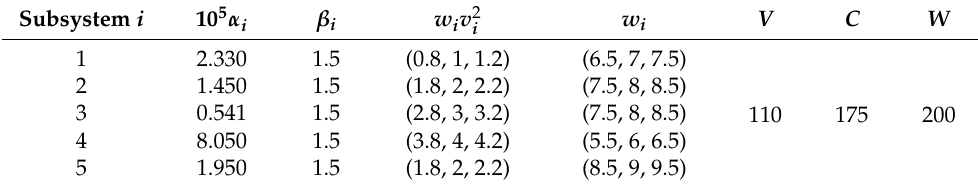
Table 1. Data for benchmark 1 and benchmark 3 [24,34,37].